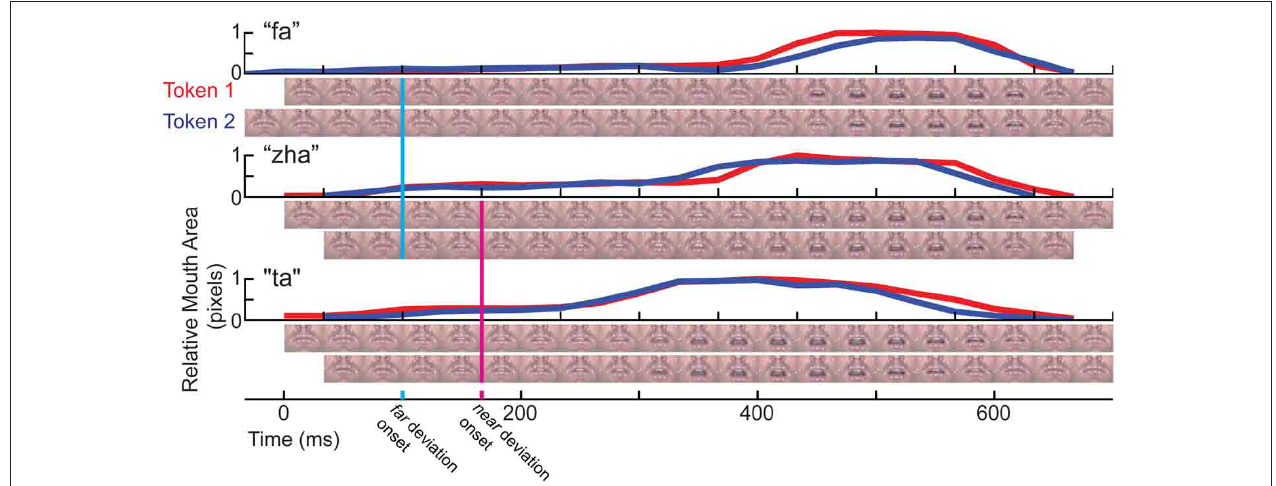
FIGURE 2 | Temporal kinematics of the syllables. For each syllable, “fa,” “zha,” and “ta,” mouth opening area was measured in pixels, normalized to the range 0 (minimum for that syllable) to 1 (maximum for that syllable). Below each mouth opening graph are two rows of video images, one for